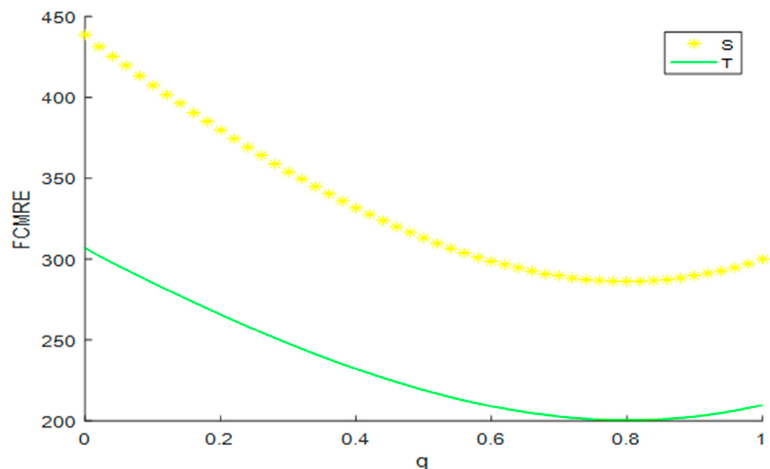
Figure 2. The fractional cumulative residual MRE of S 1 , S 2 follows a uniform distribution on [ 0, 8 ] and [ 0, 3 ] , and T = 0.5 S 1 . Figure 3 uses aeroengine time series to verify that FCMRE also has linear properties. EPR and N1 represent engine pressure ratio and high-pressure respectively. The entropy graphs of randomly generated sequences and the entropy curves of aeroengine gas path data prove the universality of property 5.